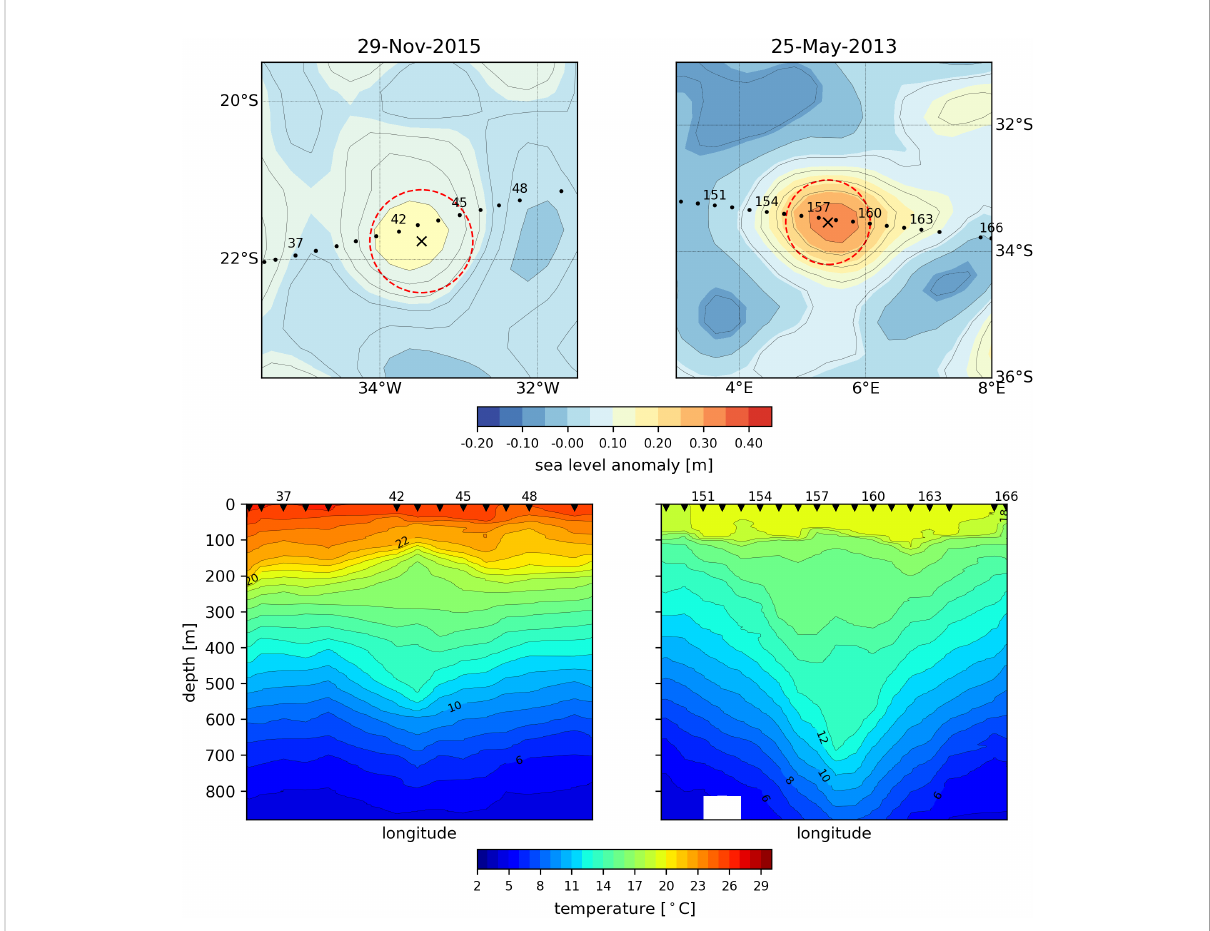
FIGURE 13 Temperature sections were sampled across the Ring Jeannette in the Cape Basin (right) and next to the Brazilian coast (left) in May 2013 and November 2015. The top panels show altimetric maps with numbered XBT deployments. The red circle delimits the area de fi ned by one ring radius (72 km in Nov/2015 and 74 km in May/2013). The bottom panels show the temperature